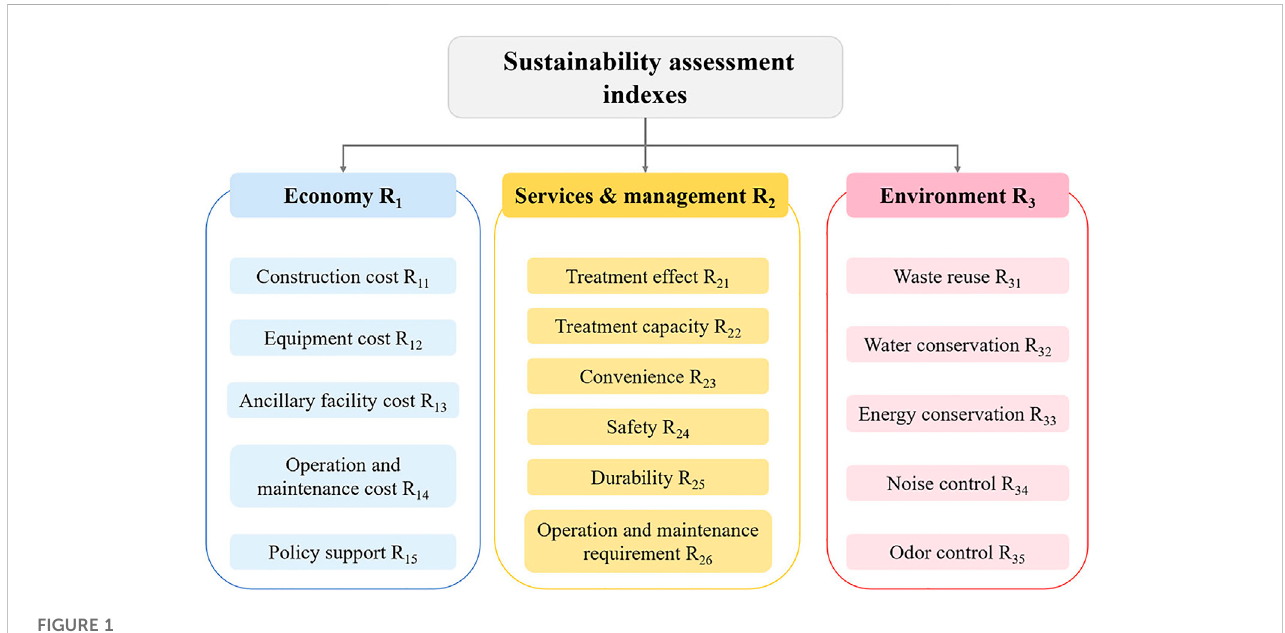
Sustainability assessment indexes of the rural toilet